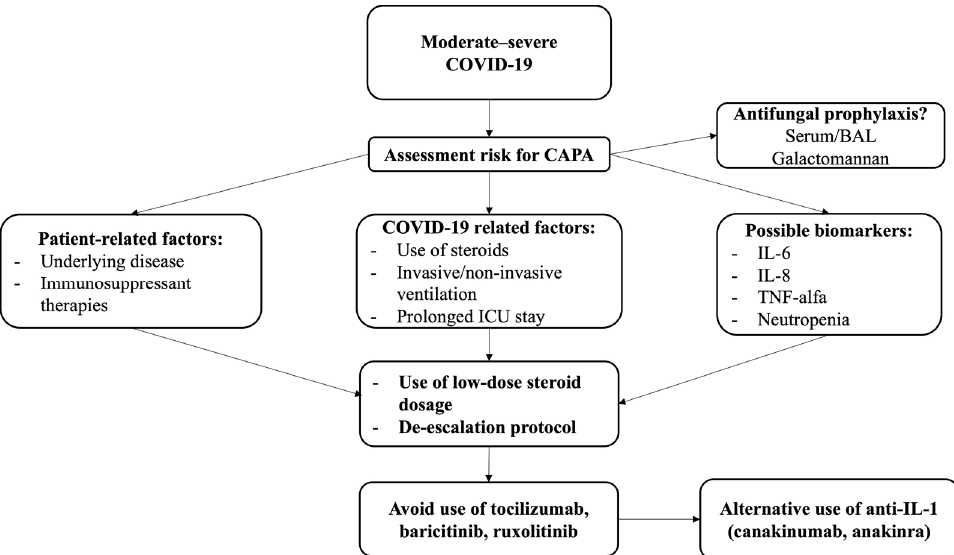
Figure 2. Strategies for the prevention of IPA in COVID-19. Legend. IPA: invasive pulmonary aspergillosis; CAPA: COVID-19 associated pulmonary aspergillosis; BAL: bronchoalveolar lavage; ICU intensive care unit; IL: interleukin.